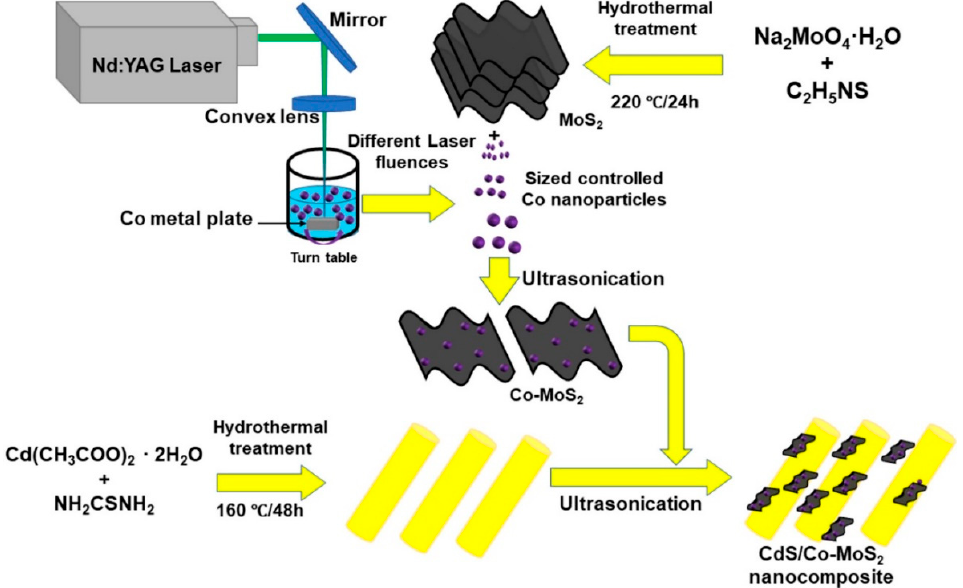
Figure 9. Schematic diagram of the synthesis of CdS/Co-MoS 2 nanocomposites. (1) The size-controlled Co nanocrystal was prepared by pulsed laser ablation of target metal plate in liquid under different laser fluences. (2) Formation of bulk MoS 2 nanosheets through hydrothermal synthesis method. (3) Preparation of few-layer Co-MoS 2 nanocomposites by ultrasonication. (4) Integration of ultrathin Co-MoS 2 nanosheets on as-prepared CdS nanorods by ultrasonication and longtime magnetic stirring to generate interfacial contact between CdS and Co-MoS 2 nanostructures. Reprinted with permission from Ref.